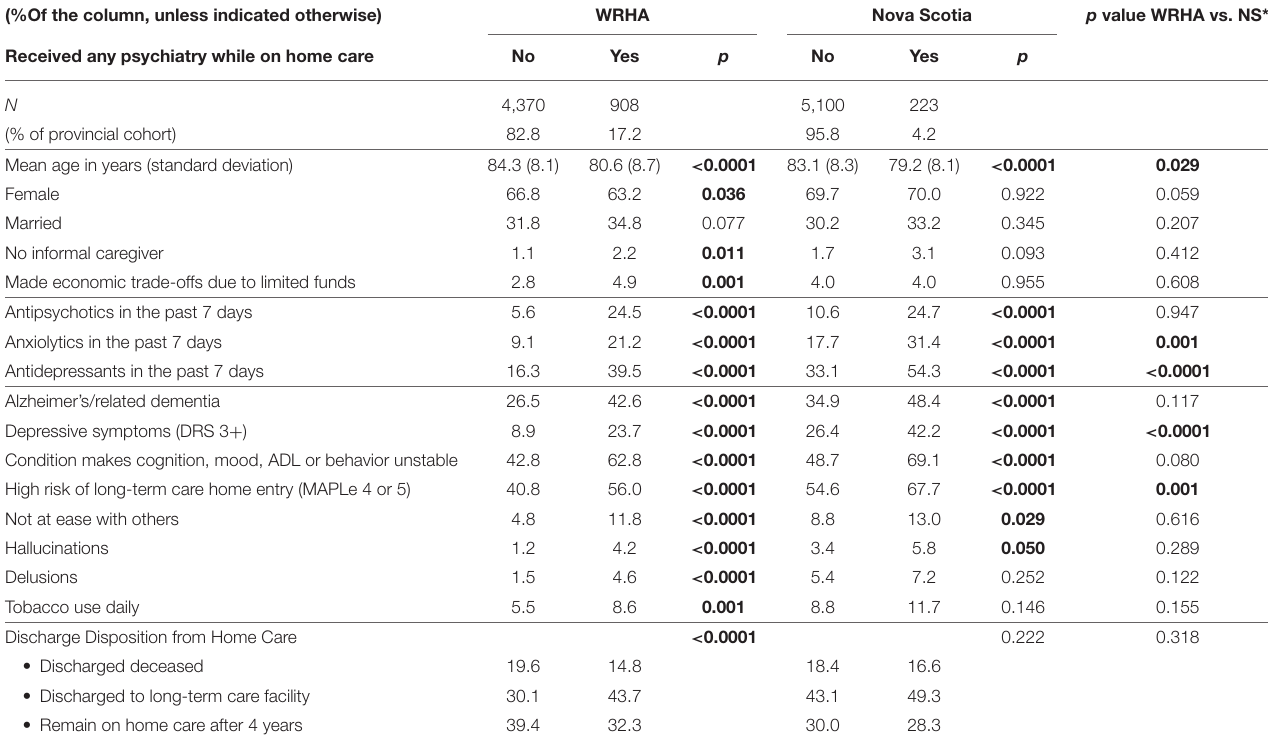
TABLE 2 | Sample characteristics at latest RAI-HC assessment, those with and without psychiatry visit. (%Of the column, unless indicated otherwise) WRHA Nova Scotia p value WRHA vs.